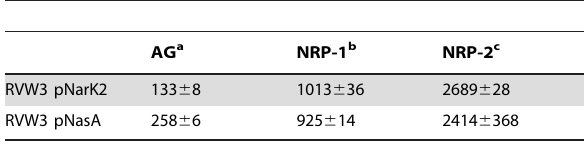
Table 1. Nitrite levels in M. tuberculosis expressing B. subtilis nasA or M. tuberculosis